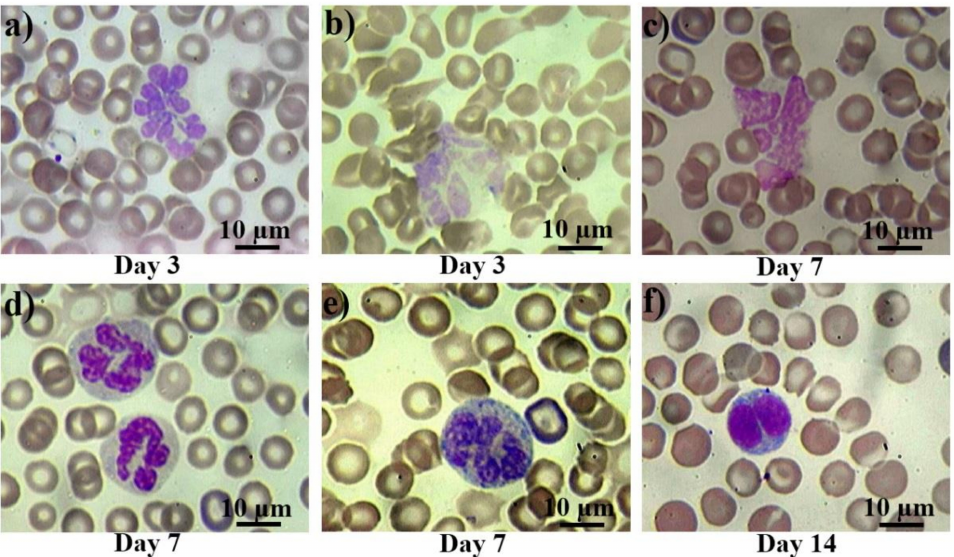
Figure 2. Pathological white blood cells in control rats and those exposed to the laser-driven UPEB irradiation. Hypersegmented ( a ) and pathological ( b ) giant neutrophils on the 3rd day after electron beam exposure; destroyed giant neutrophil ( c ), normally segmented giant neutrophils with basophilic cytoplasm ( d ), and severe basophilic granular cytoplasm ( e ) on the 7th day after irradiation exposure; and bilobed (binuclear) lymphocyte ( f ) on the 14th day after electron beam exposure. Blood slides were stained by Giemsa modified solution. Cells were examined under the light microscope at 1250 × magnification. Scale bar is 10 µ